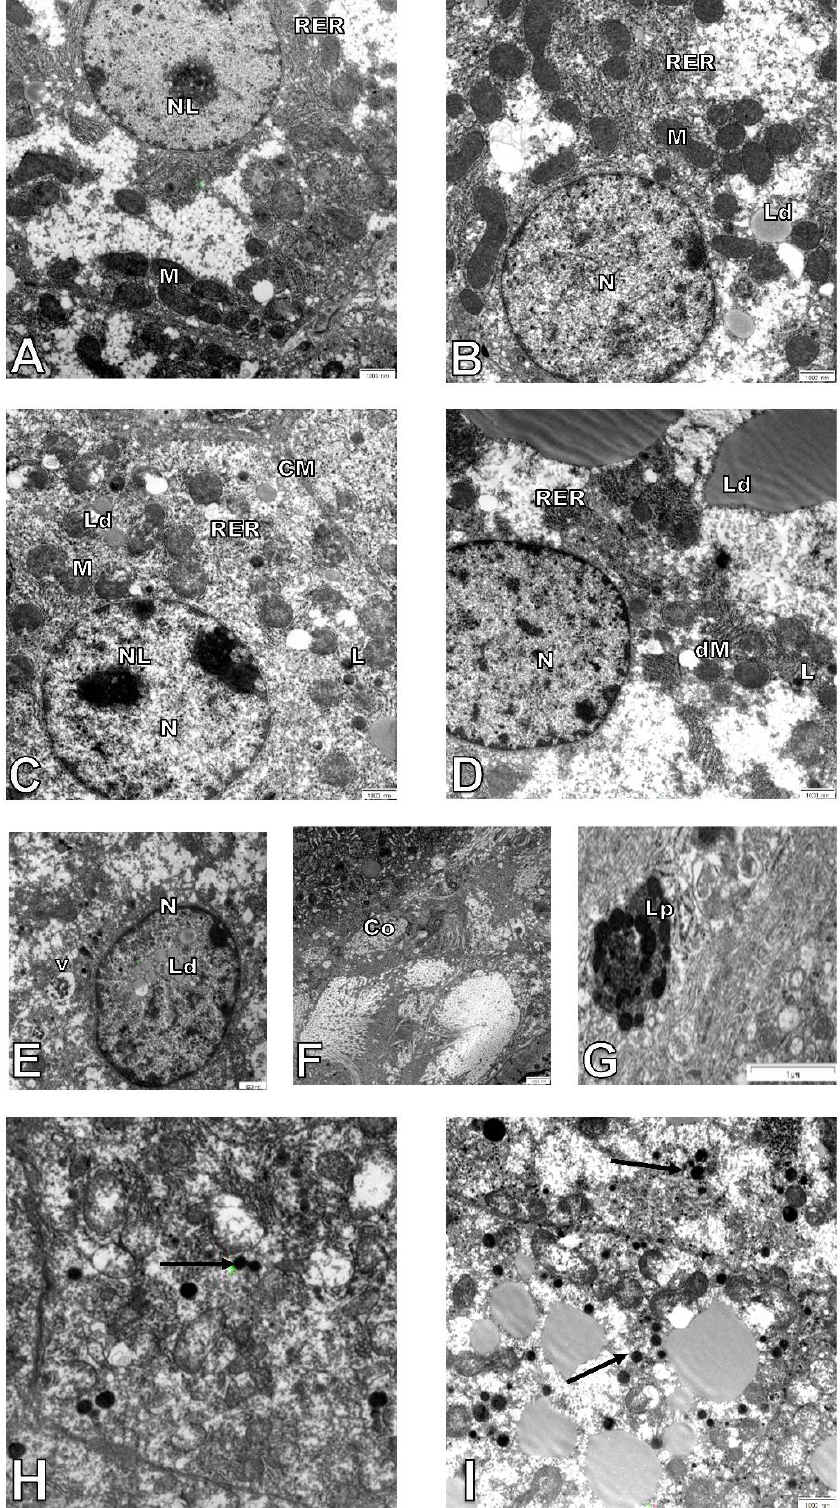
Figure 3. Age-related changes in hepatocyte ultrastructure. Seven-month-old ( A ) and 17-month-old C57Bl/6J mice ( C , H ); 7-month-old ( B ), and 17-month-old Apo E − / − mice ( D – G , I ). CM—cell membrane, Lp—lipofuscin, Ld—lipid droplets, L—lysosomes, M—mitochondria, dM—damage mitochondria, N—nucleus, NL—nucleolus, RER—rough endoplasmic reticulum, V—vacuoles, Co—collagen. Arrows show lysosomes in older animals. Scale bar = 1000 nm.